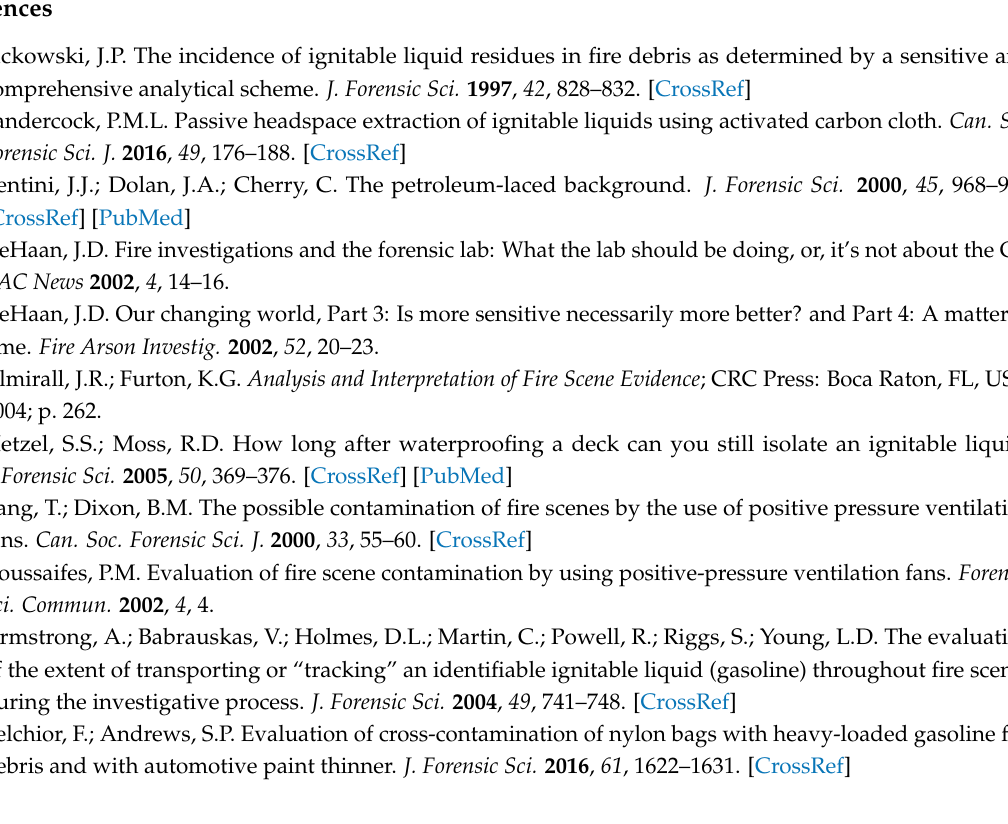
Supplementary Materials: Supplementary materials including chromatograms, and a brief description of criteria used to identify ignitable liquids are available online at